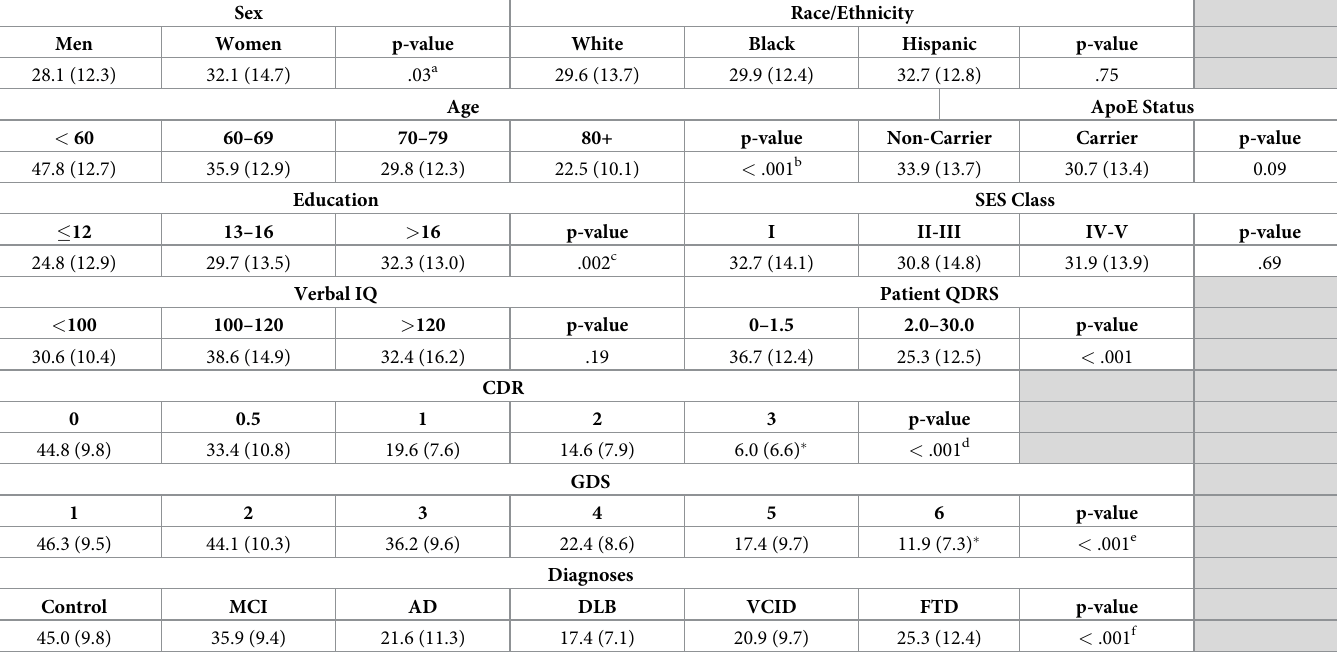
Table 3. Performance of Number-Symbol Coding Task by demographics, staging, and diagnoses. Sex